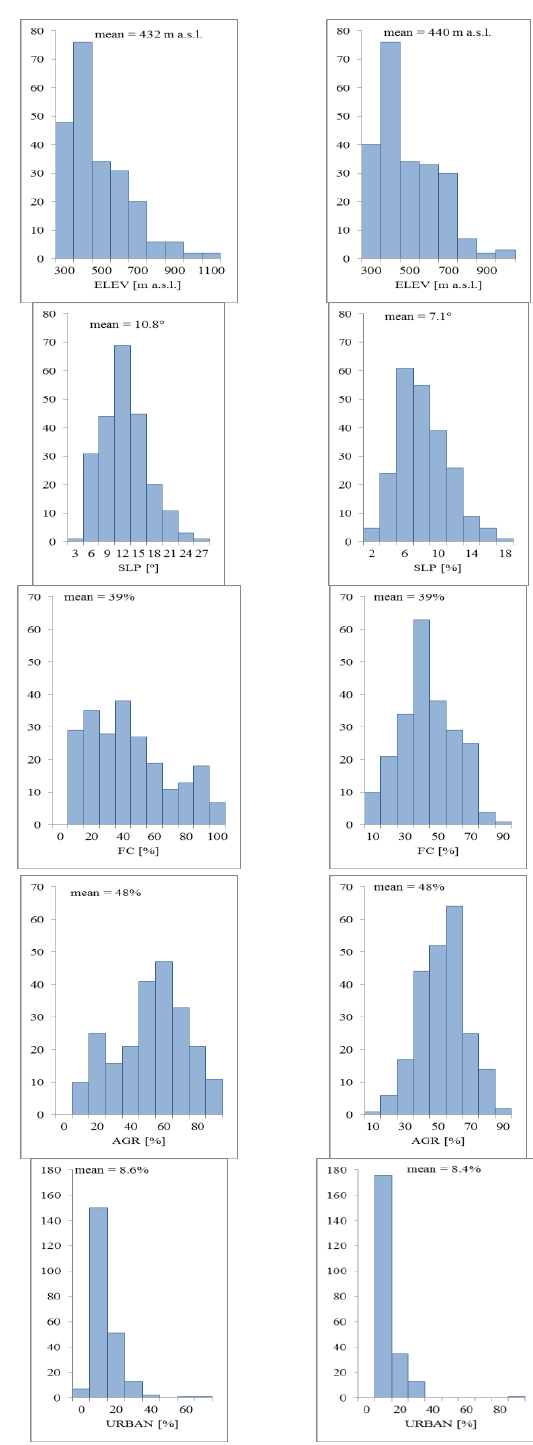
Figure 3. Distribution of selected variables in the sample tiles (left) and communes